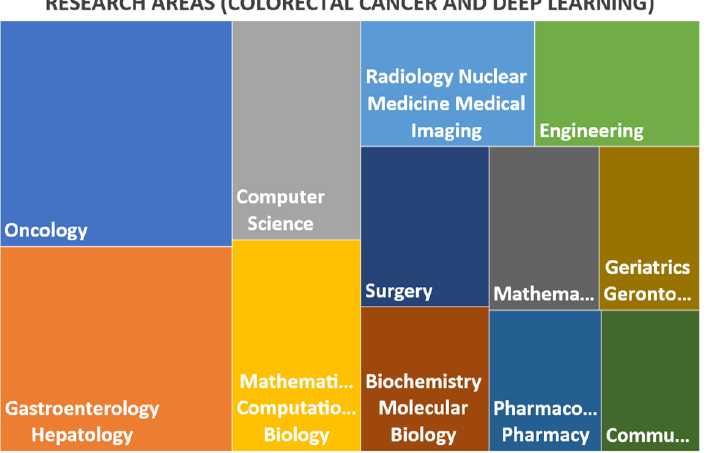
Figure 2. Analysis of publications by research area, in the field of deep learning techniques applied to colorectal